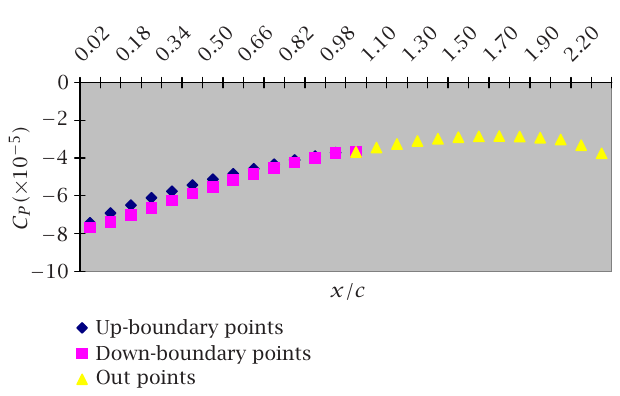
Figure 6.7 . Pressure distribution around the aircraft of Figure 5.1, for linear vortex distribution and speed 4Mach.